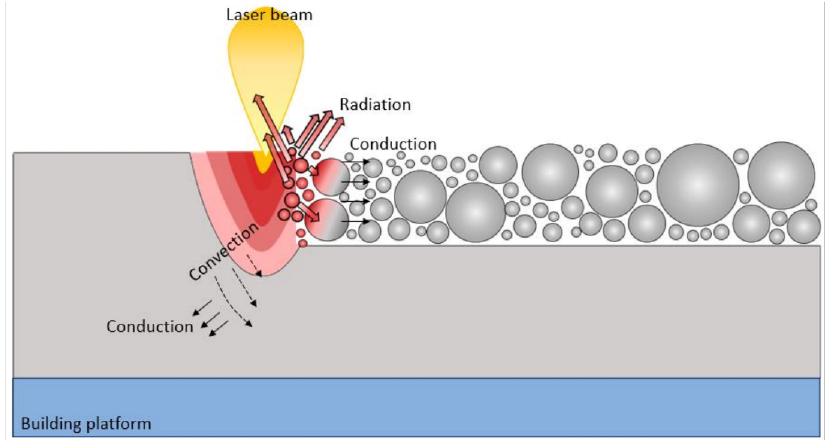
Figure 7. Physical phenomena involved in the PBF-LB/M